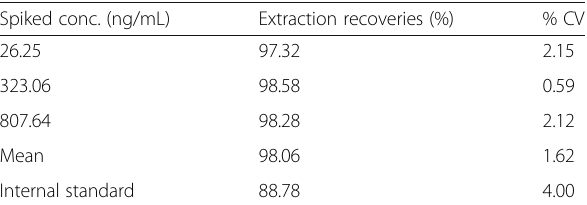
Table 3 Extraction recoveries of lenalidomide and IS in human plasma Spiked conc. (ng/mL)